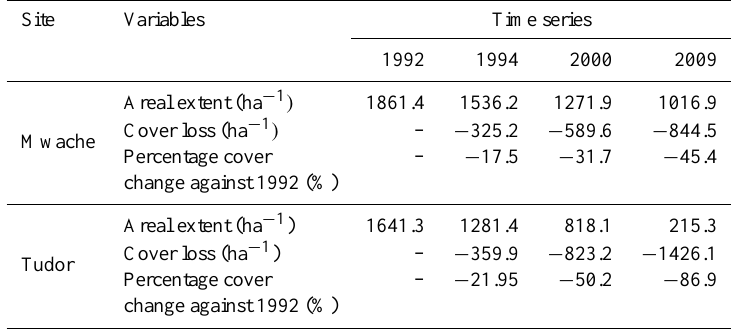
Table 4. Mangrove cover change over the years.